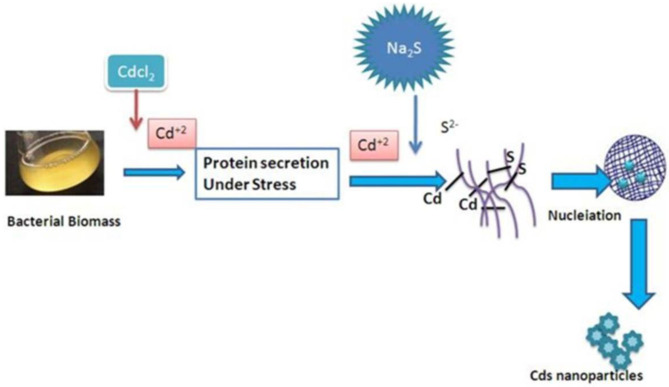
Green synthesis of nanoparticles by plants.